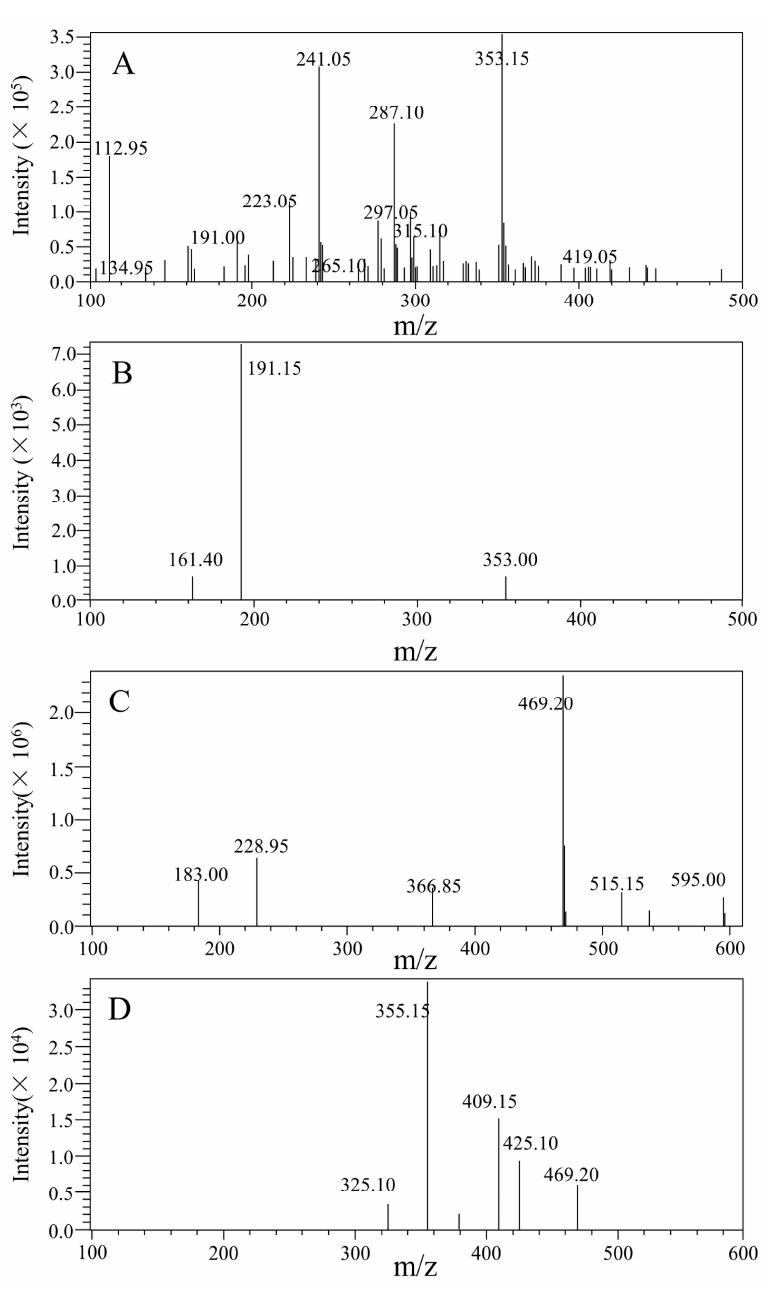
Figure 2. Full-scan precursor ion and production spectra of 5-CQA and GA. ( A ) Full-scan precursor ion spectra of 5-CQA; ( B ) full-scan product ion spectra of 5-CQA; ( C ) full-scan precursor ion spectra of GA; ( D ) full-scan product ion spectra of GA.